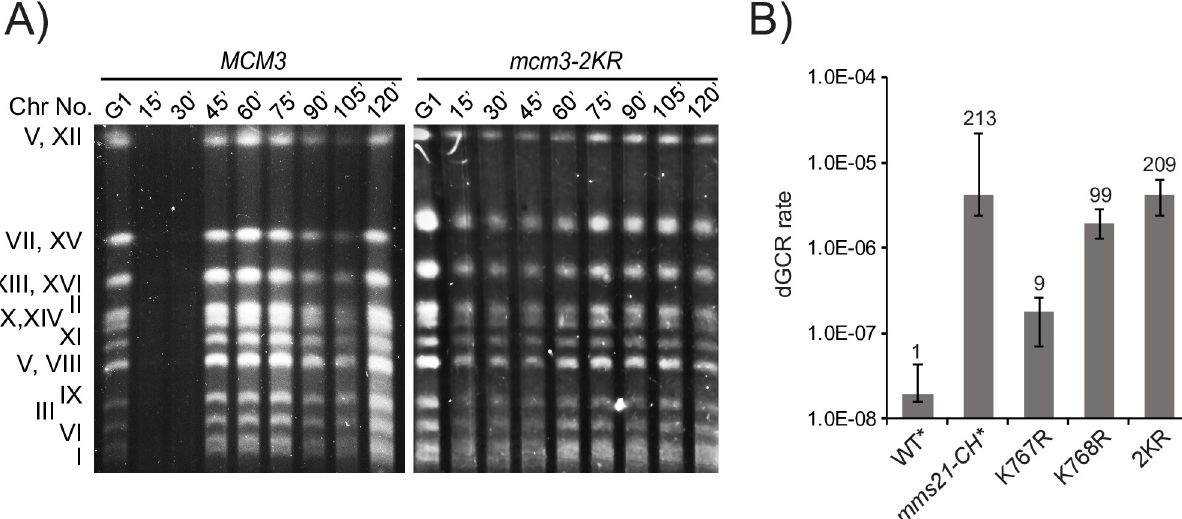
Fig 6. mcm3-2KR revealed reduced chromosomal replication, and drastic accumulation of dGCRs. (A) PFGE analysis of yeast chromosomes in WT and mcm3-2KR cells released from G1-arrest. Distinct chromosome bands correspond to fully replicated chromosomes. (B) Rates of accumulating dGCRs in mcm3 mutants, showing the fold-increase caused by K767R, K768R, and 2KR mutations; dGCR rates of WT and mms21-CH were taken from a previous study for comparison